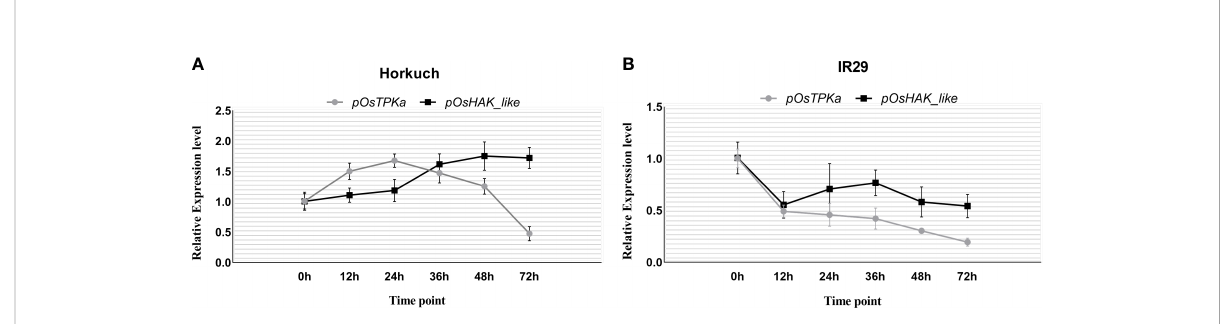
FIGURE 2 Coordinated expression analysis of OsTPKa and OsHAK_like in Horkuch (A) and IR29 (B) .